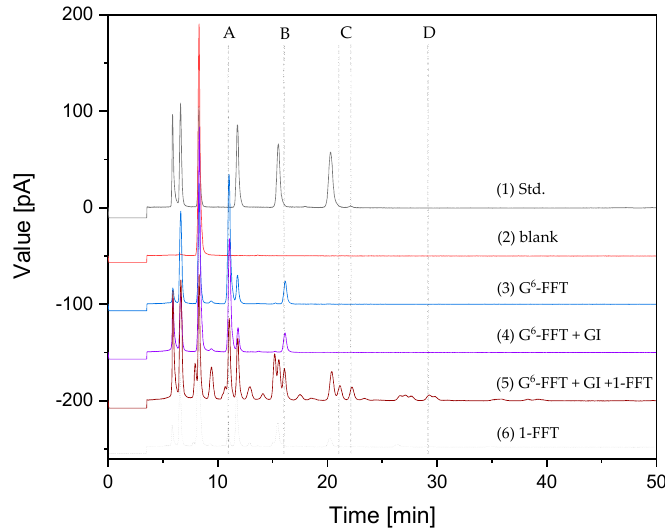
Figure 11. Chromatogram showing FOS standards and the two-step 100-mL scale production of neoFOS. Offset = 50 pA. The peaks correspond to ( A ) neokestose, ( B ) putative neonystose, ( C ) putative neoFOS with four fructose units (GF 4 ), and ( D ) putative neoFOS with five fructose five units (GF 5 ). The total yield of the two-step process was 47.02 ± 3.02%, which was determined with respect to the total available sucrose concentration (Table 1). The putative neo-GF 4 product reached a concentration of 20.8 ± 1.91 mM. During the reaction, the distribution of products shifted toward FOS with higher degrees of polymerization. Table 1. Substrate/product concentrations in a two-step neoFOS production process at the 100-mL scale showing each consecutive production step: (A) blank, (B) products of G 6 -FFT catalysis, (C) products of glucose isomerase, (D) concentrations following the addition of crystalline sucrose, and (E) products of 1-FFT catalysis. Process Step